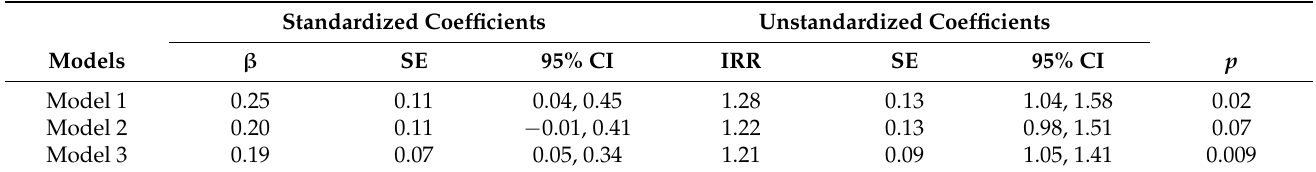
Table 2. Models estimating the association between PPT concussion treatment modality and